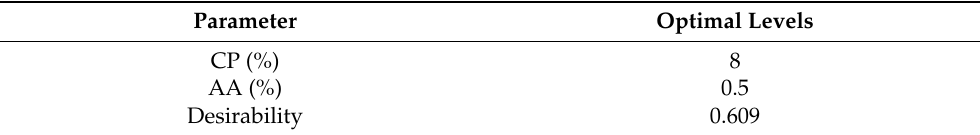
Table 7. Optimal levels of CP and AA obtained by RSM.